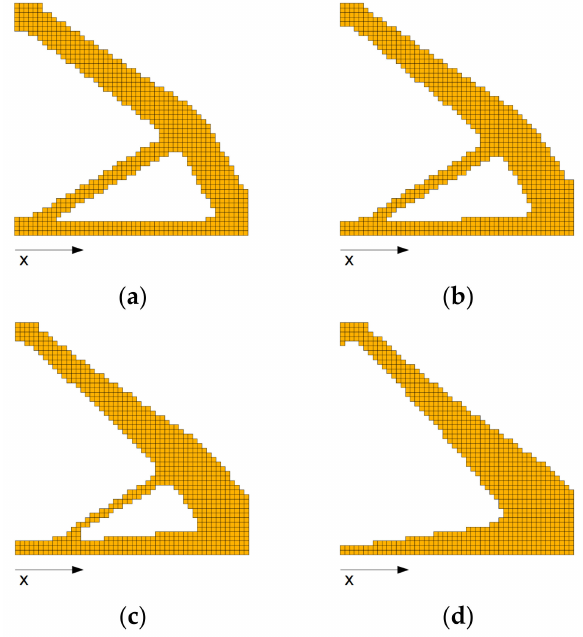
Figure 6. Final topologies found for square structure using the FGM-RAMP material interpolation scheme, x -direction of material gradation: ( a ) α = − 0.02, minimal compliance: 4.338 Nm; ( b ) α = − 0.04, minimal compliance: 7.794 Nm; ( c ) α = − 0.06, minimal compliance: 15.173 Nm; ( d ) α = − 0.08, minimal compliance: 31.512 Nm.